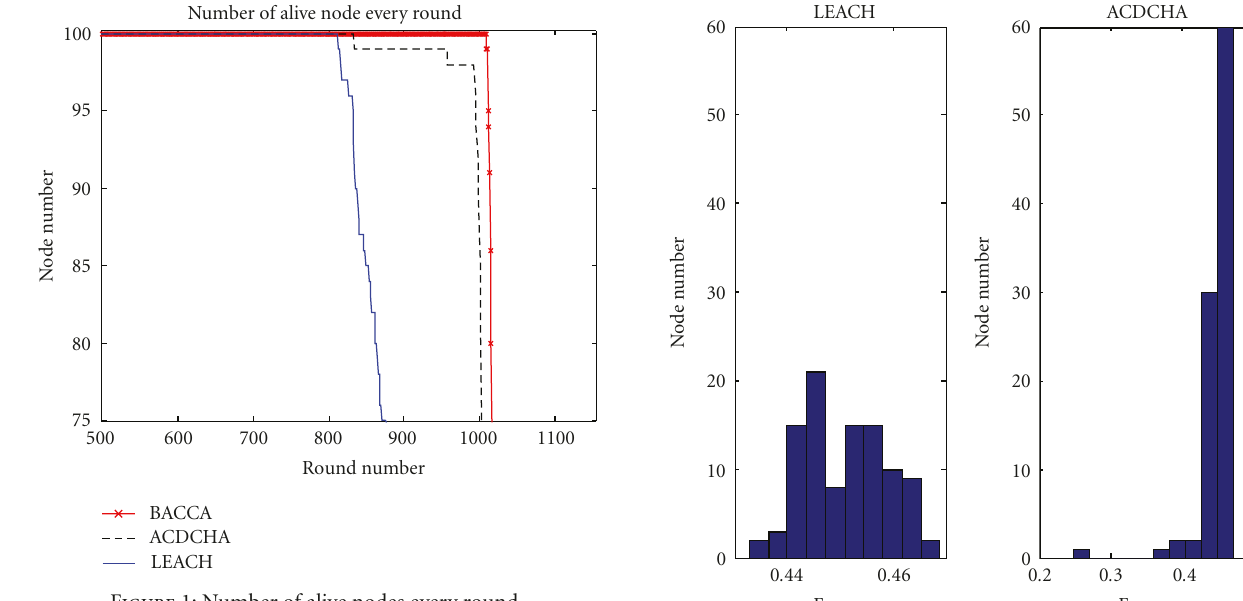
Figure 1: Number of alive nodes every round.